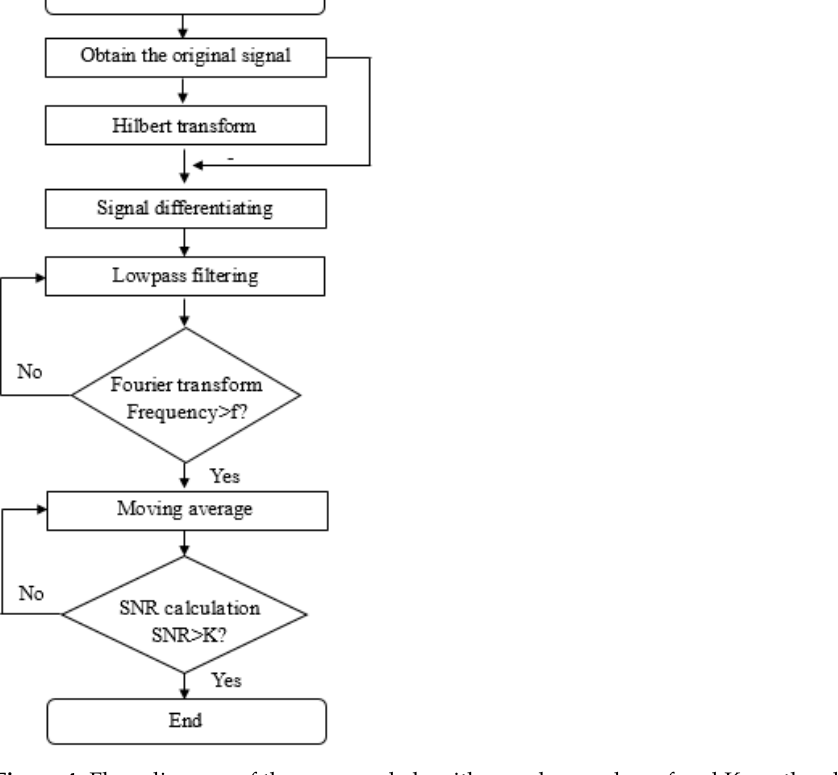
Figure 4. Flow diagram of the proposed algorithm and procedure. f and K are threshold values of the frequency and SNR.